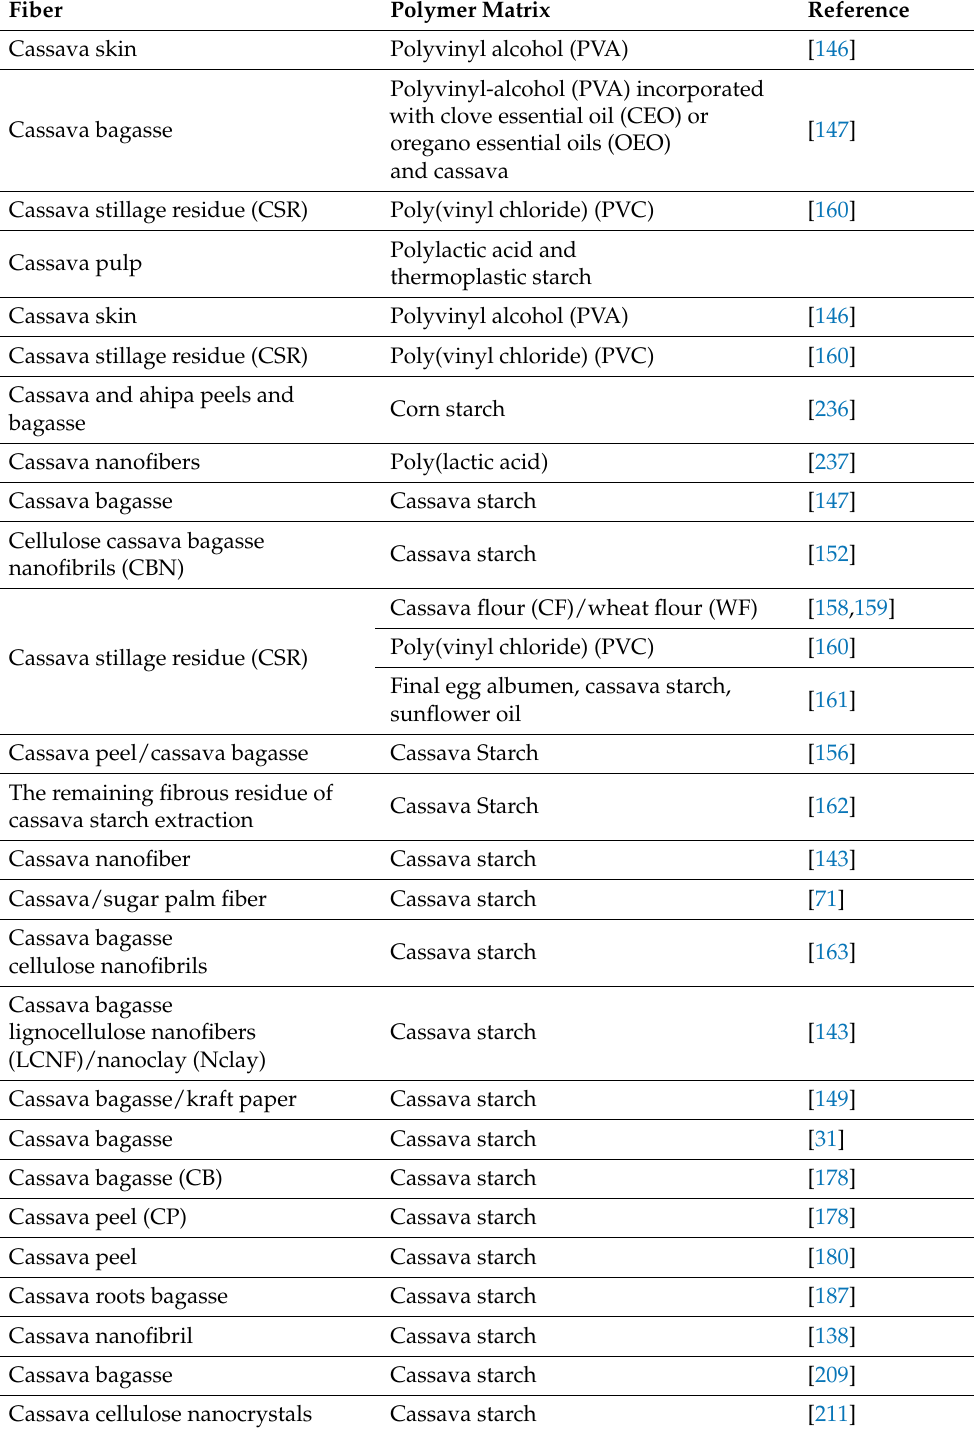
Table 11. Reported work on cassava fiber-reinforced polymer